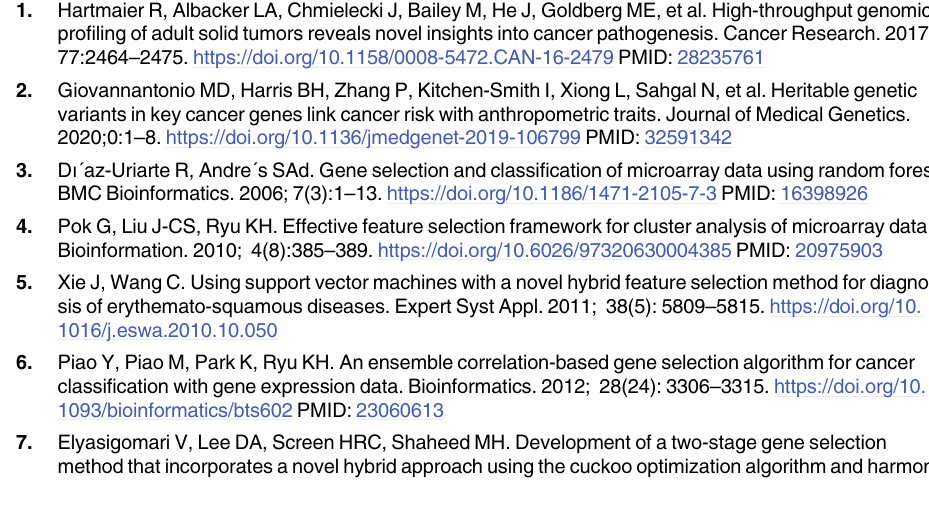
S3 Fig. Polylines of classification metrics of the Sort Difference Backward Elimination